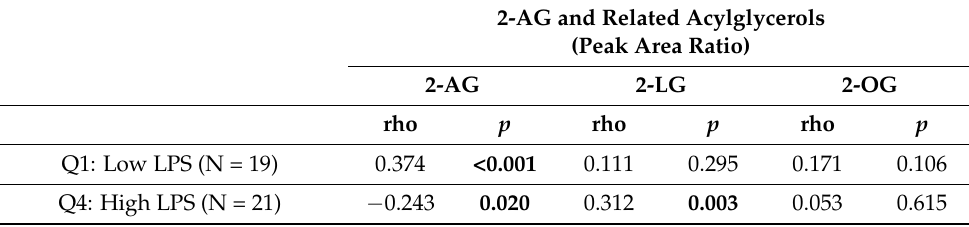
Table 4. Partial Spearman correlation of plasma levels of 2-AG and related acylglycerols with plasma levels of lipopolysaccharide in participants who showed very low and high values (EU/mL) adjusted for body mass